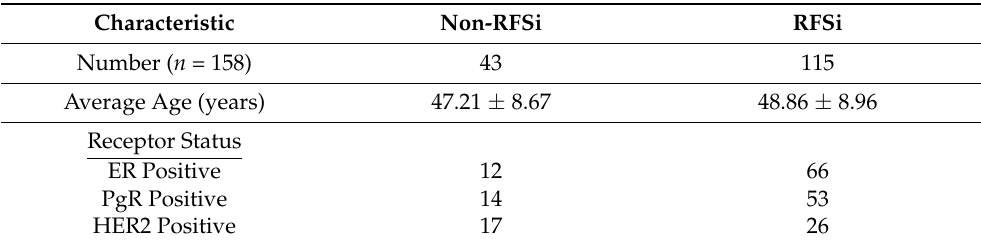
Table 1. Clinical specifications of the patients involved in the study. The acronym non-RFSi indicates non-recurrence-free patients and hence those patients who showed recurrence. The acronym RFSi stands for recurrence-free patients and hence those patients who did not show